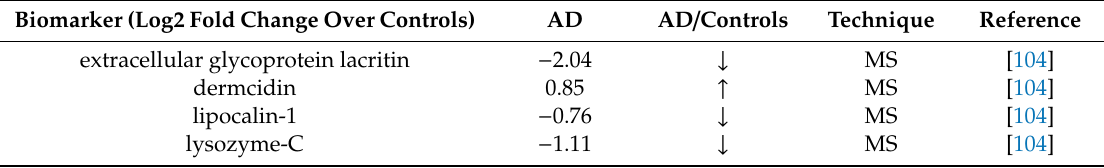
Table 5. Changes in levels of biomarkers in tears from AD patients and controls.